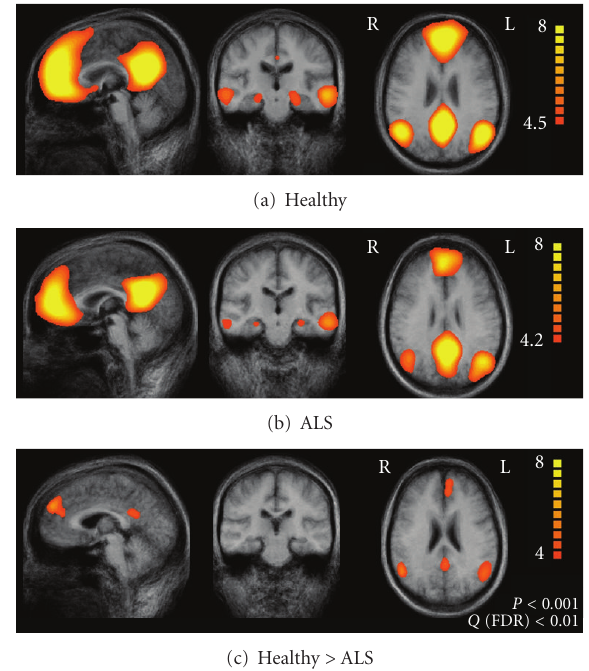
Figure 4: Default-mode network. Upper row (a) illustrates the result of the group ICA analysis for the healthy control participants. The middle row (b) illustrates the results for the ALS patients. The statistical comparison is shown in the lower row (c). Adapted from Mohammadi and coworkers